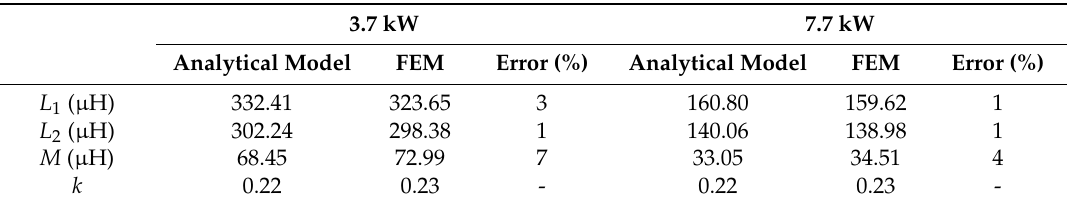
Table 3. Verification parameter of the 3.7 kW and 7.7 kW WPT systems.